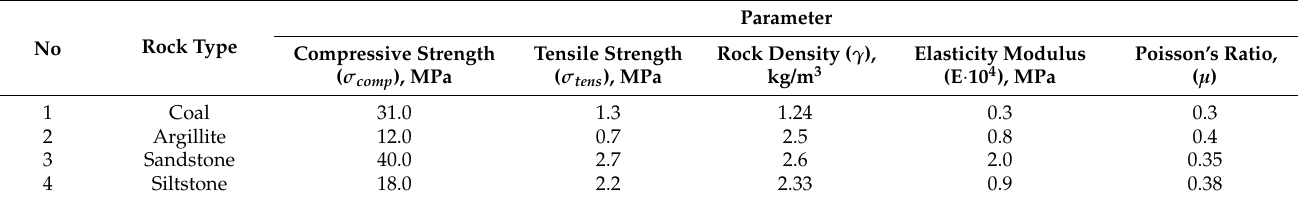
Table 1. Physical-mechanical characteristics of the coal-bearing rock